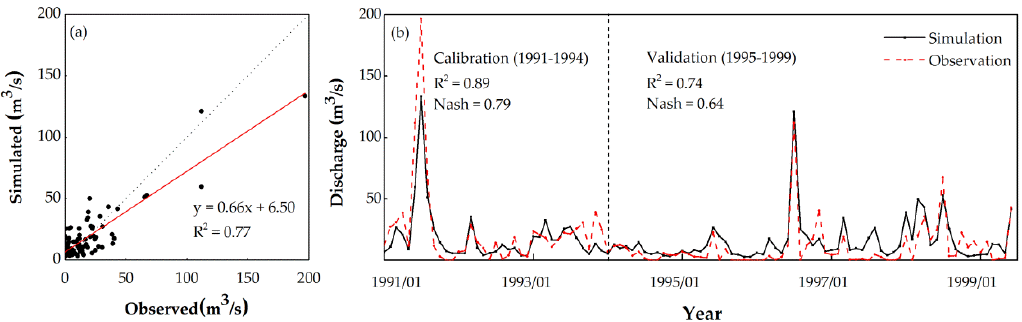
Figure 3. Monthly discharge simulated by the MIKE SHE model versus observed discharge at Wudingmen gauging station: ( a ) scatter plot for the period from 1991 to 1999; and ( b ) simulated (continuous line) and observed (dotted line) monthly hydrographs for the calibration (1991–1994) and validation (1995–1999).